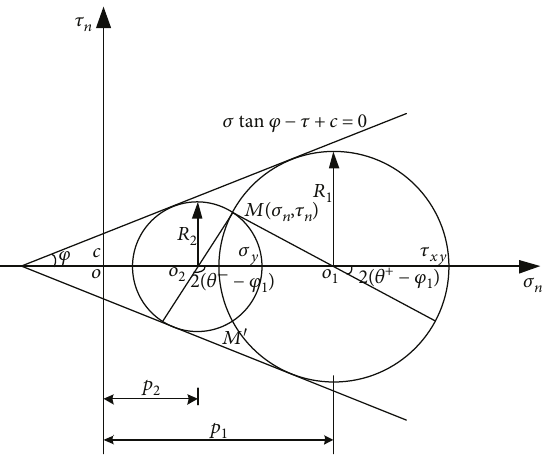
Figure 2: Mohr ’ s circles on noncharacteristic line stress